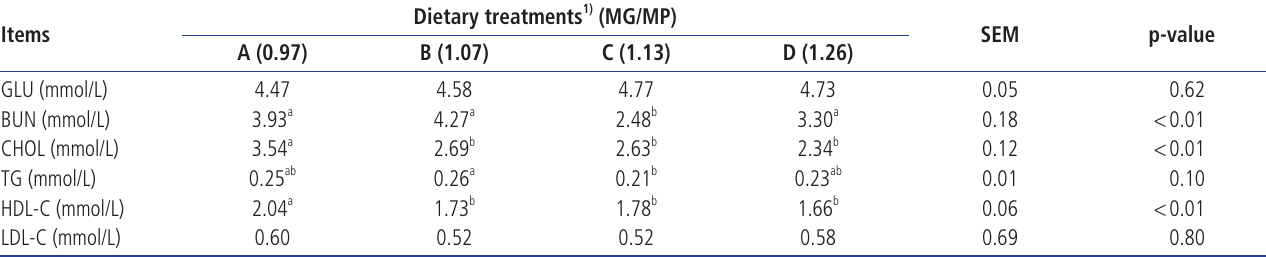
Dietary treatments 1)